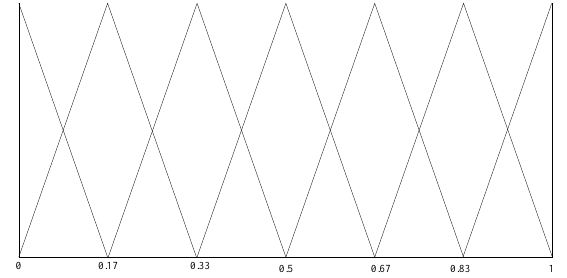
Fig. 3. Symmetrically Distributed Linguistic Term Set